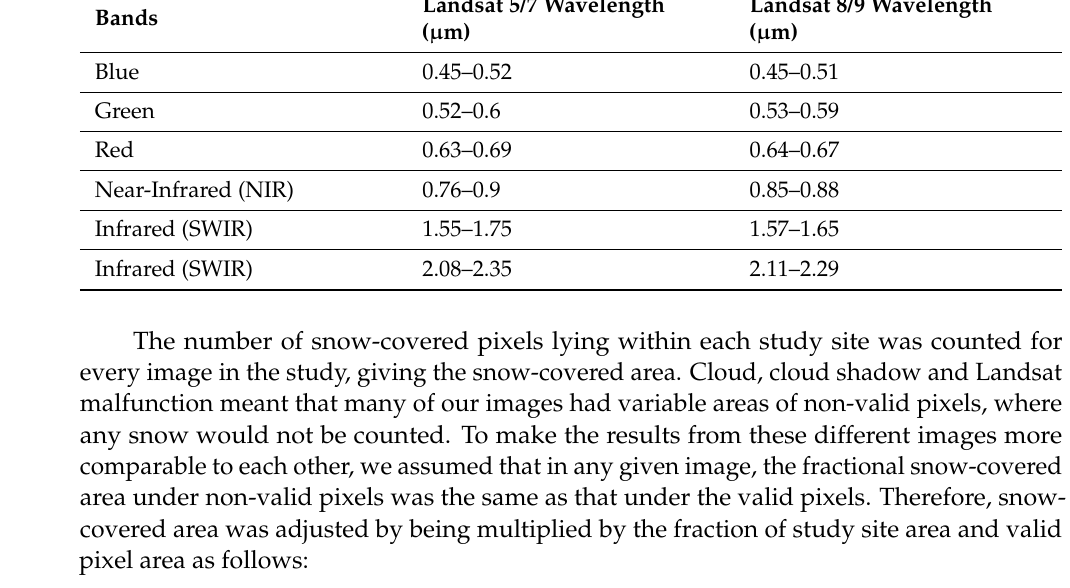
Table 1. Wavelengths of Landsat satellites. All the featured bands have a resolution of 30 m. Landsat 5/7 Bands